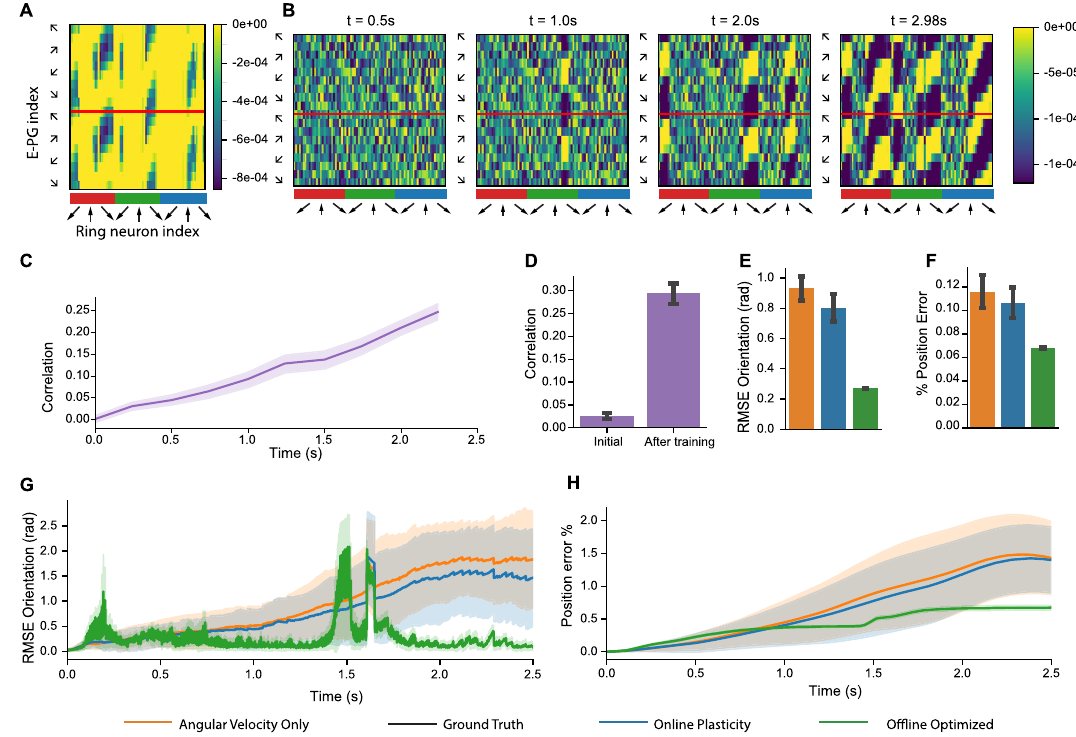
r → c Figure 6. Model evaluation on a robotic platform. ( A ) Offline optimized W has a banded structure which represents an optimal set of weight to map visual features in ring neurons to orientation representation in E-PG neurons. ( B ) Evolution of weights during online plasticity increases in similarity to offline optimized weights over time. ( C–D ) The correlation between online learned weights and the offline optimized solution increases over time. ( E ) The average orientation RMSE (in radians) is less with online plasticity than angular velocity alone. ( F ) Average position error as a percentage of path length has similar trends as orientation estimation with less differentiation between online learning and angular velocity alone. ( G ) In estimated orientation RMSE over time, error increases in periods with visual feature dropout with offline optimized weights. ( H ) Position error as a percentage of path length over time. All group level analyses in ( C–H ) are performed for 50 simulated seeds. ( C–F ) have 95% bootstrapped confidence intervals, ( G–H ) have standard deviation confidence